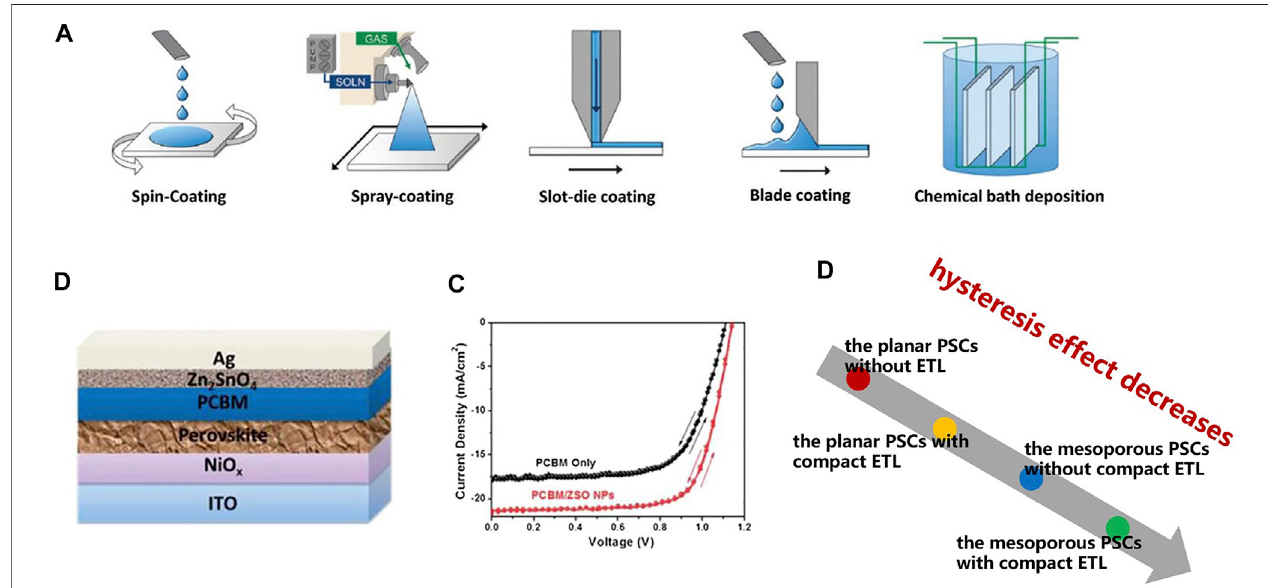
FIGURE 3 | (A) Schematic diagram of spin-coating, spray-coating, slot-die coating, blade coating, and chemical bath deposition. (B) Schematic diagram of Zn 2 SnO 4 /PCBM double-layer ETL PSCs and its (C) J-V curve. (D) The effect of ETL structure on the hysteresis of